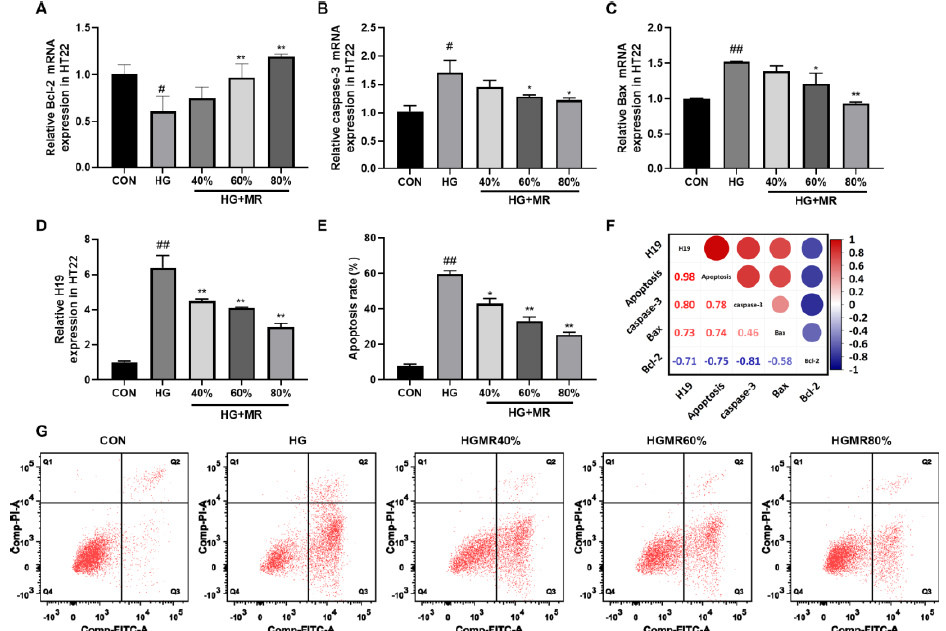
Figure 7. Effects of MR on HT22 cell apoptosis induced by HG. ( A − D ) Relative Bcl-2, caspase-3, Bax mRNA, and H19 expression in HT22 cells treated with HG (225 mM) and different levels of MR. ( E , G ) The apoptosis of HT22 cells treated with HG (225 mM) and different levels of MR is presented by flow cytometry. ( F ) Pearson’s correlations among H19, apoptosis, caspase-3, Bcl-2, and Bax. The size and color of the circles in the upper right corner of the matrix indicate the correlation index level (red denoting a positive correlation and blue denoting a negative correlation), while the bottom left corner of the matrix contains the associated correlation index’s numerical value. All data are shown as the mean ± SEM. # p < 0.05, ## p < 0.01 (versus CON); * p < 0.05, ** p < 0.01 (versus HG).